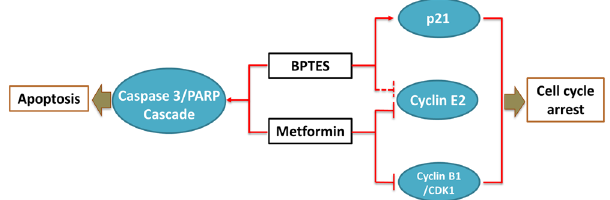
Figure 6. Schematic model depicting the regulatory effect of BPTES and metformin on cell cycle and apoptosis pathways in HNSCC. BPTES reduces the expression of cyclin E2 (in Fadu cells only) and promotes the expression of p21 to induce G2-phase arrest. Metformin decreases CDK1/Cyclin B1 expression and almost totally eliminates Cyclin E2 expression to induce G1-phase arrest. Both BPTES and metformin are able to initiate apoptosis by inducing the cleavage of Caspase 3/PRAP